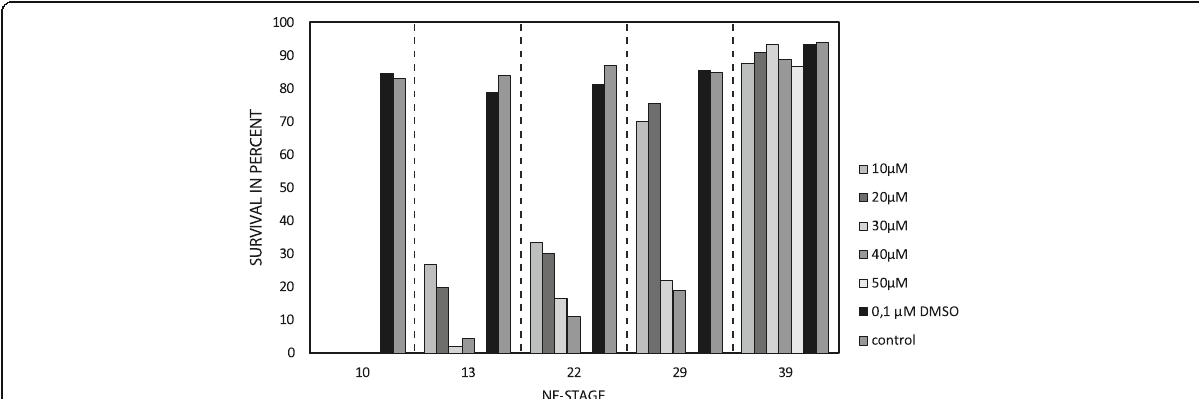
Fig. 1 Quantitative analysis of X. laevis tadpole survival after Ly-294,002 treatment. X. laevis larvae were treated with different amounts of Ly-294,002 at different developmental stages until NF 45. As controls, X. laevis larvae were raised either in 0,1 μ M DMSO or in 0,1× MBS. Larvae treated with DMSO and with 0,1× MBS show no significant differences in survival rates. The survival rate in Ly-294,002 treated larvae declines with increasing Ly-294,002 concentration and early start of the incubation